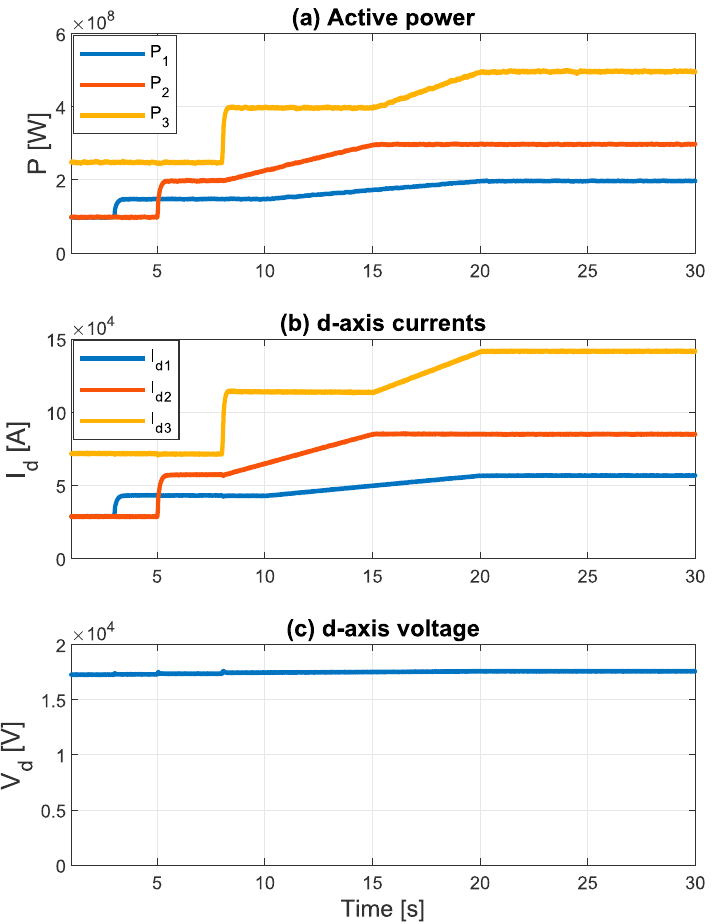
Figure 14. ( a ) Active power and ( b ) d-axis currents supplied by the individual inverters; ( c ) d-axis voltage (PCC voltage).